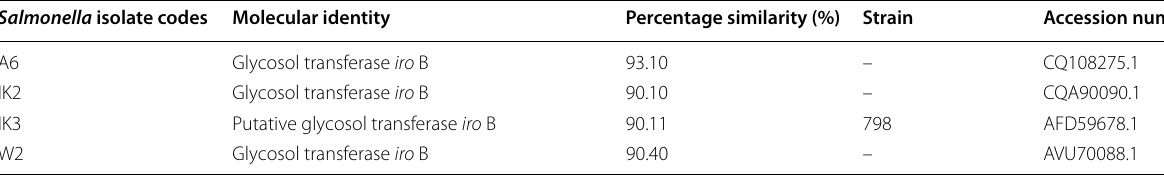
A, Akure; IK, Ikare; W, Owo